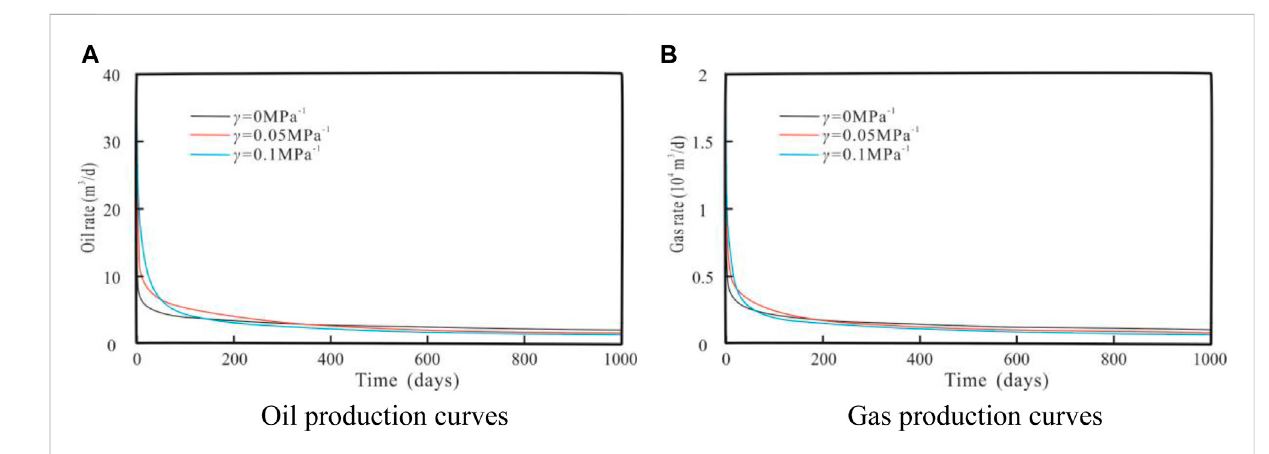
FIGURE 6 Effect of perm e ability modulus on production dynamic curves.